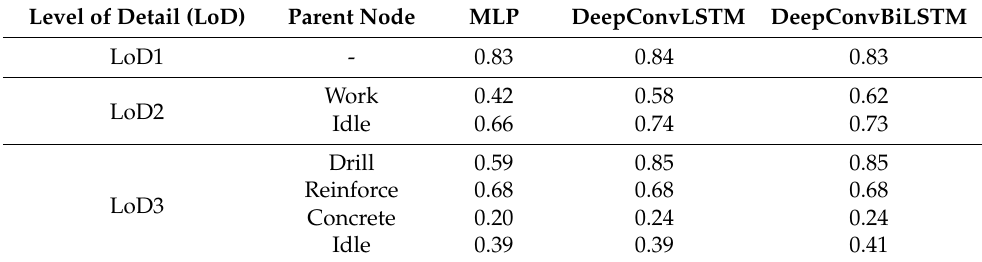
Table 3. F1 scores for the selected activities.